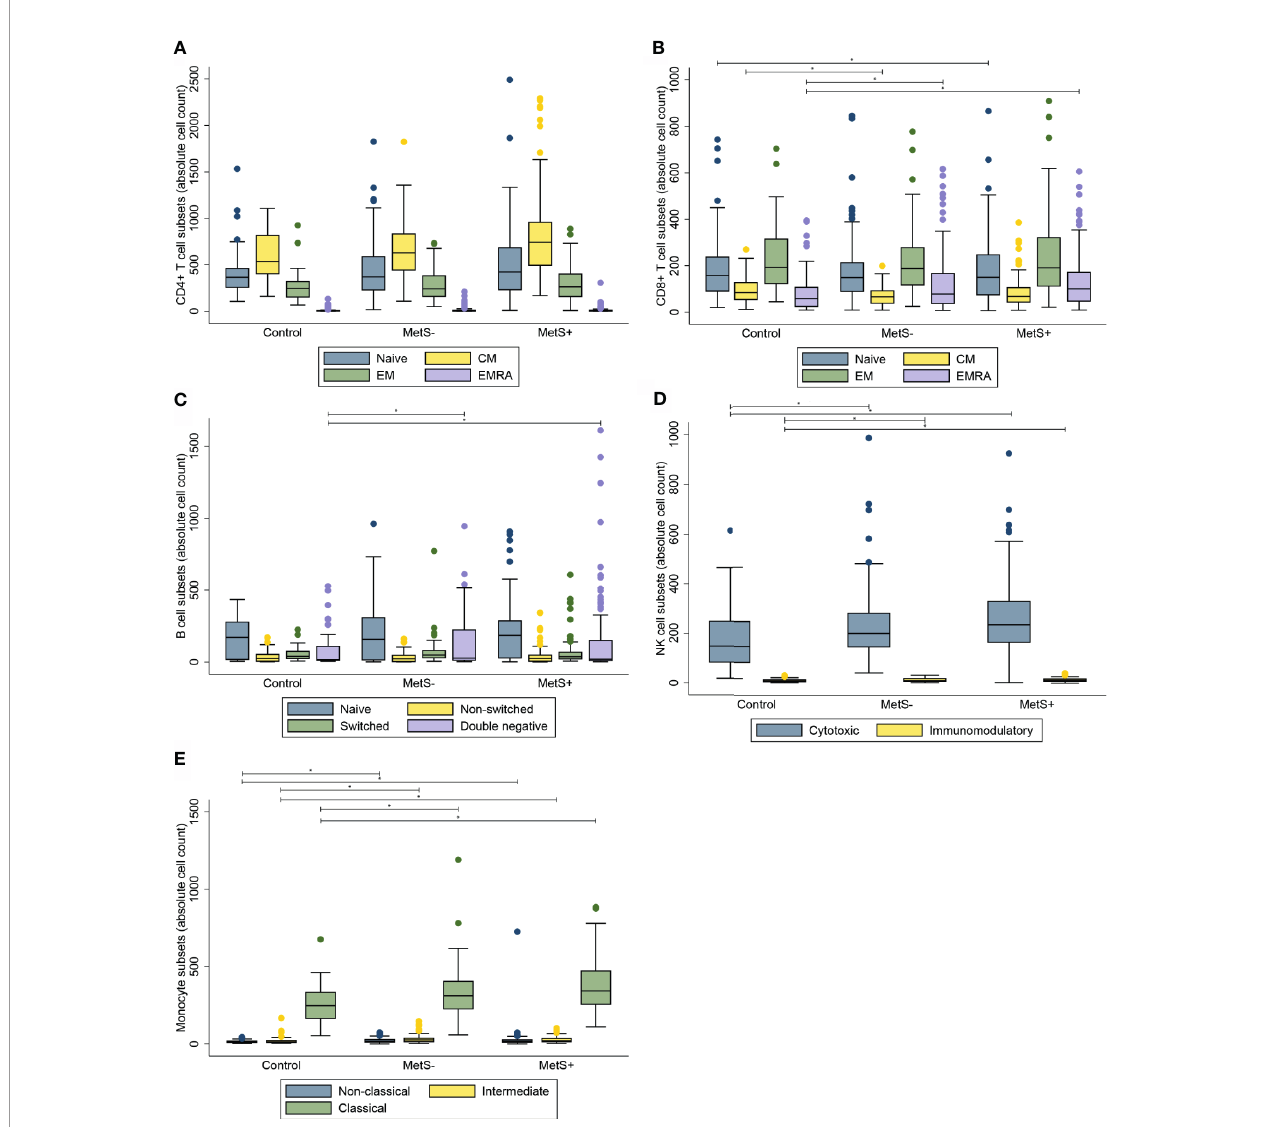
FIGURE 2 | Composition of immune cell subsets in percentages. (A) CD4+ T cell subsets. (B) CD8+ T cell subsets. (C) B cell subsets. (D) NK cell subsets. (E) Monocyte subsets. MetS- = morbidly obese patients without metabolic syndrome; MetS+, morbidly obese patients with metabolic syndrome; CM, central memory; EM, effector memory; EMRA, terminally differentiated effector memory. * P < 0.05.